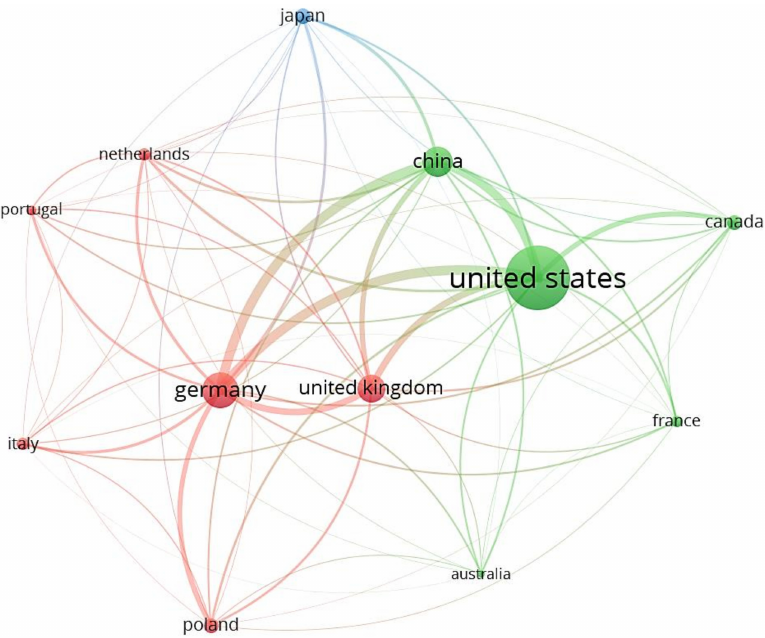
Figure 5. Mapping of countries active in SCT-related